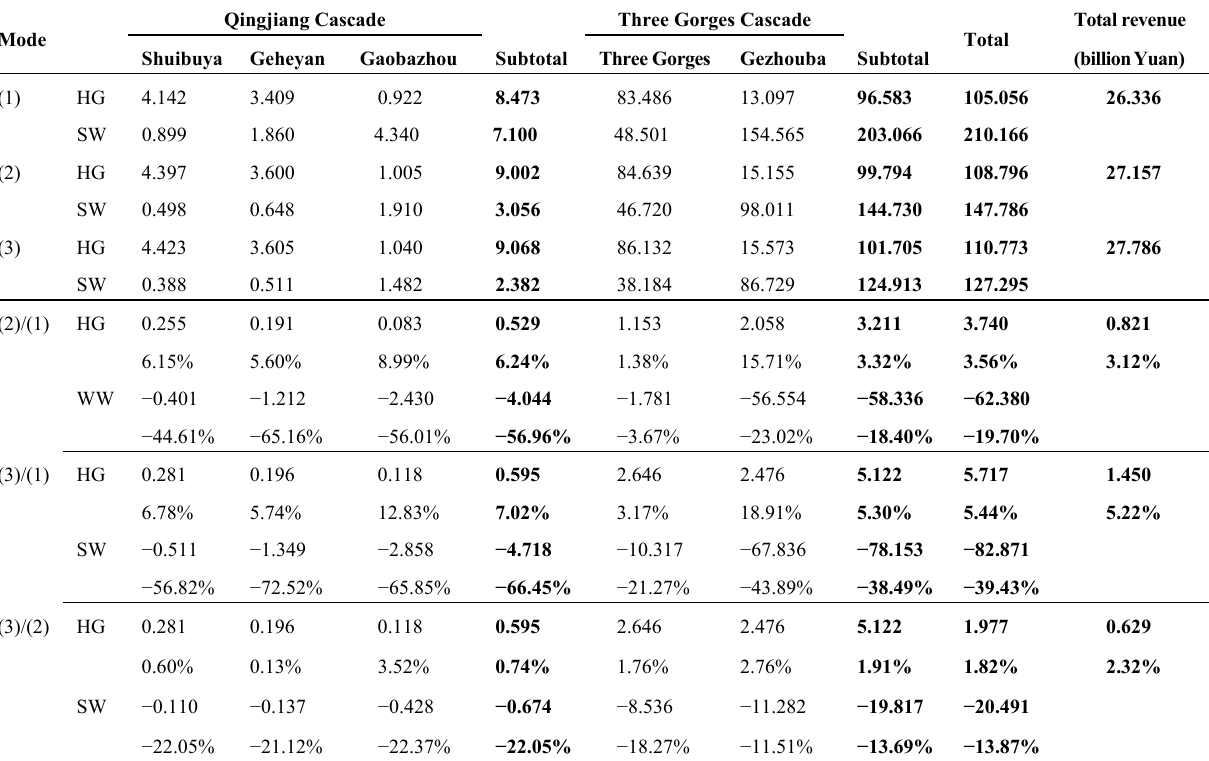
Table 5. Estimated hydropower generation (billion kWh) and spilled water (billion m 3 ) by objective function of maximum hydropower